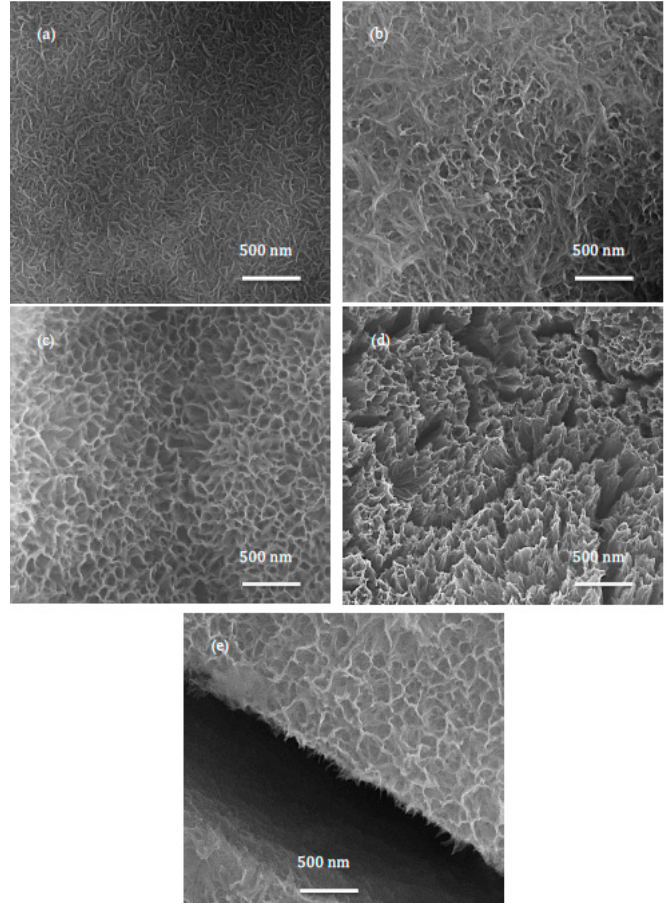
Figure 3. SEM images of ( a ) TNF80, ( b ) TNF100, ( c ) TNF120, ( d ) TNF140, and ( e ) side view of TNF120. Numbers at TNF are the temperature [°C], in which the system was created.